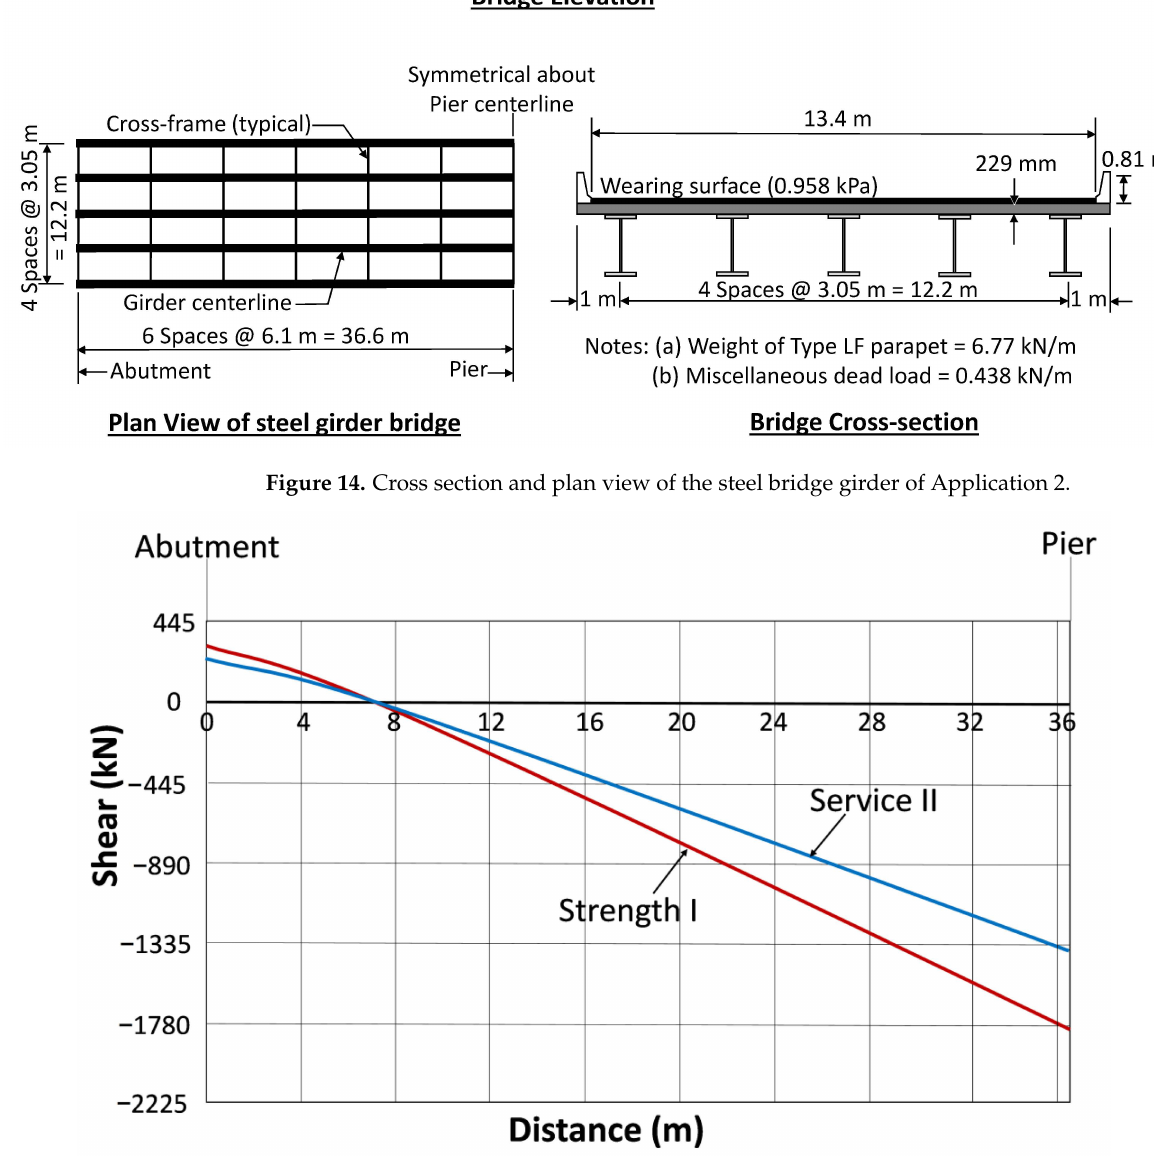
Figure 15. Shear diagrams per girder on one span of the